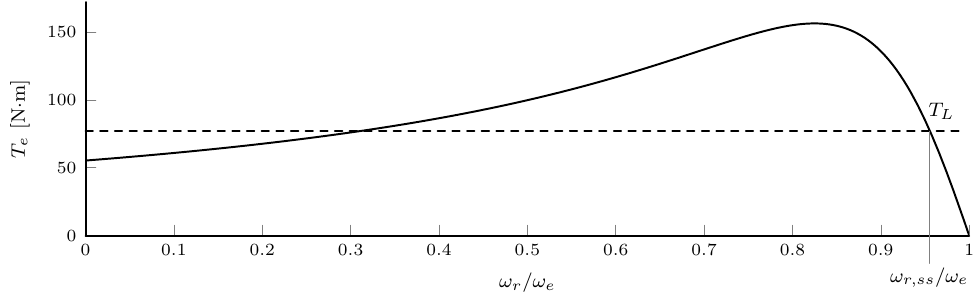
Figure 9. Steady-state torque vs. normalized speed curve indicating steady-state operating speed, ω r , ss , for applied torque load, T L